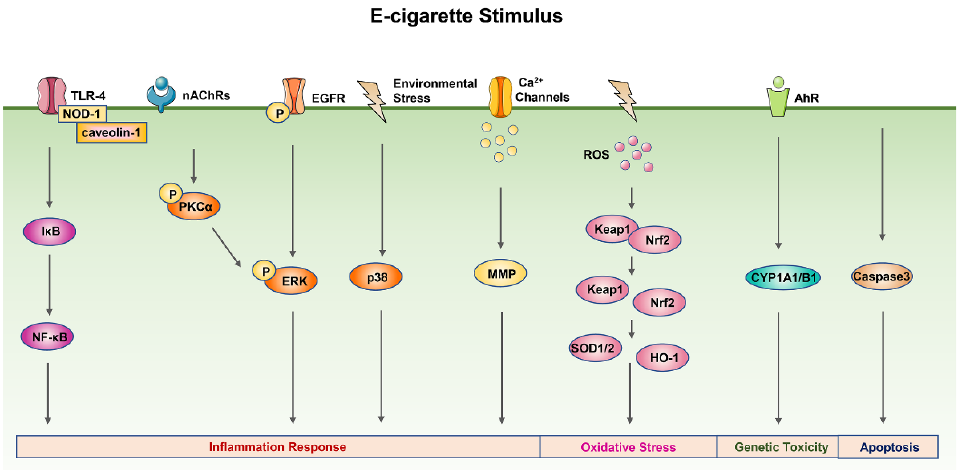
Figure 3. The signal pathways of e-cigarette toxicity mechanisms. E-cigarette smoke exposure can also activate the p38 MAPK, TLR-4/NF- κ B, and EGFR/ERK signal pathways to promote the release of inflammatory mediators. The PKC α /ERK pathway is stimulated by e-cigarette smoke through the nicotinic receptors α 7nAchR to cause inflammation response. E-cigarette smoke exposure can increase cytoplasmic Ca 2+ to induce MMP protease release and increase the risk of lung damage. In addition, the activation of the Nrf2 signal pathway caused by e-cigarette smoke exposure following the upregulation of SOD and HO-1 could reduce lung damage. E-cigarette smoke exposure can also cause genetic toxicity via the AhR signal pathway’s activation and cell apoptosis via the caspase-3 signal pathway. Abbreviation: AhR, aryl hydrocarbon receptor; CYP1A1/B1; cytochrome P-450 1A1/B1; EGFR, epidermal growth factor receptor; ERK, extracellular regulated protein kinases; MMP, matrix metalloproteinase; NOD-1, nucleotide-binding oligomerization domain-containing protein- 1; PKCα, protein kinase C - α; SOD, superoxide dismutase; TLR -4, toll-like receptor 4.